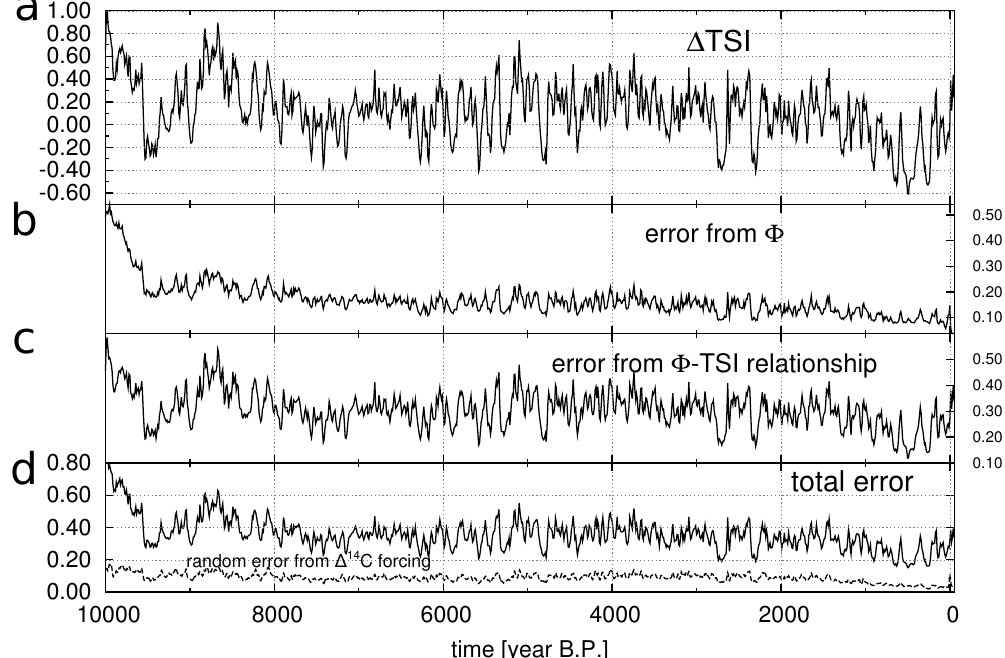
Fig. A3. Assessment of uncertainties in the 1 TSI reconstruction in Wm − 2 . (a) 1 TSI (mean of the Monte Carlo simulations), (b) the uncertainty in 1 TSI from the error of 8 , (c) from the uncertainty in the TSI– B r relationship, and (d) when considering all uncertainties in the MC calculation. Errors are 1 σ uncertainties. The dashed line shows the uncertainty introduced by random errors propagated from the 1 14 C history excluding any systematic